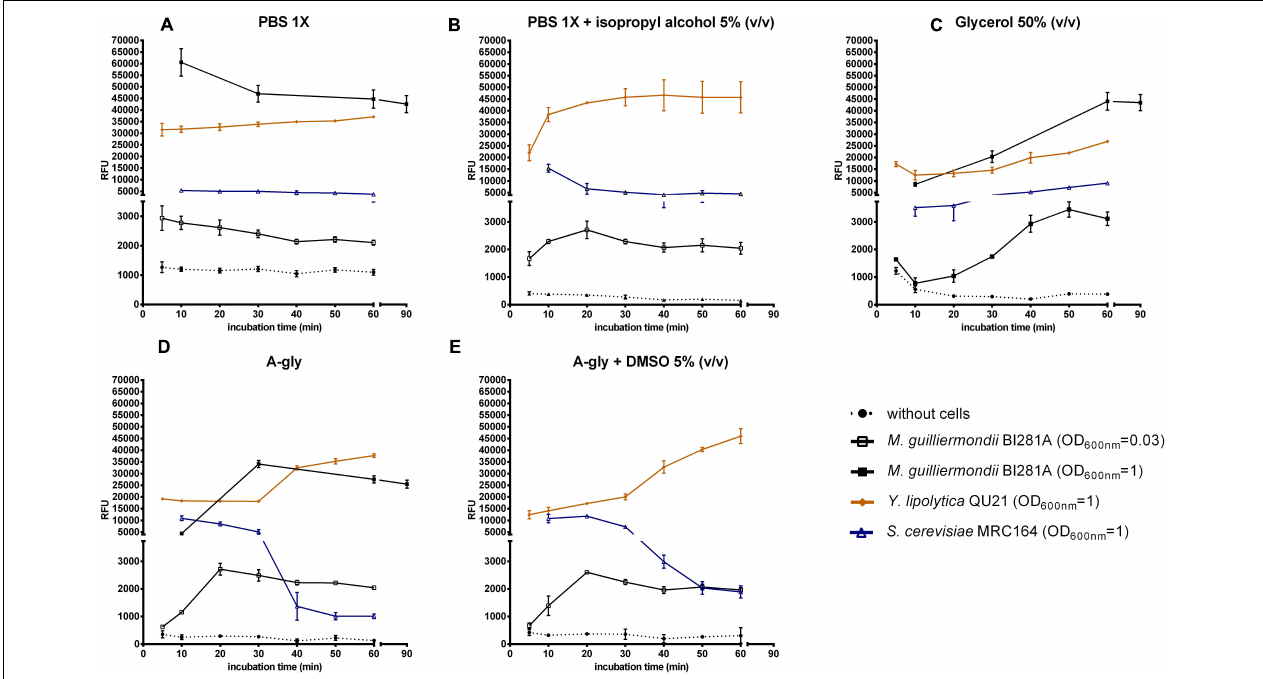
FIGURE 1 | Nile red fluorescence (RFU) against time incubation with the dye for each treatment (min). Treatments included absence (dotted lines) or presence of cells (solid lines). Yeast strains tested: M. guilliermondii BI281A (empty square, OD 600 nm = 0.03; filled square, OD 600 nm = 1; grown for 7 days in A-Gly broth), Y. lipolytica QU21 (diamond, OD 600 nm = 1; grown for 7 days in A-Gly broth), S. cerevisiae MRC164 (triangle, OD 600 nm = 1; grown for 2 days in YM broth). Solvents: PBS 1X (A) , PBS 1X with isopropyl alcohol 5% (v/v) (B) , Glycerol 50% (v/v) (C) , A-gly broth (D) , and A-gly with DMSO 5% (v/v) (E) . Y axis was split in two scales (0–4,500 RFU and 5,000–70,000 RFU). Values are means ± standard deviation ( n = 3). OD, optical